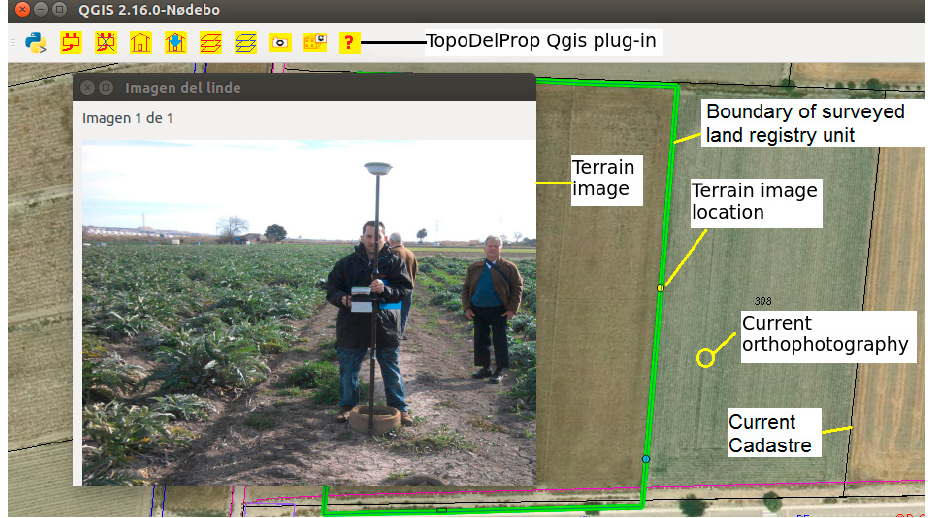
Figure 9. TopoDelProp plug ‐ in showing an image and its location on the ground. Source: own elab ‐ oration.